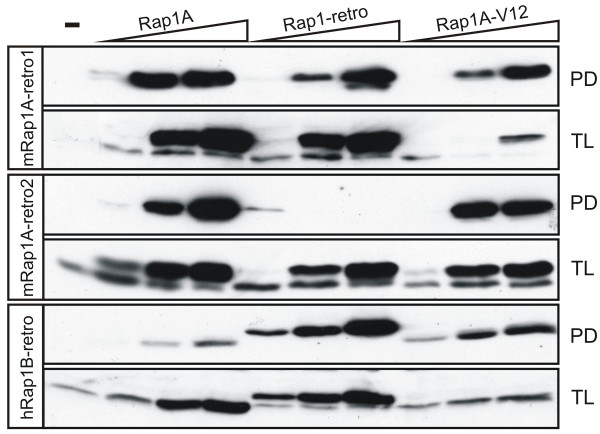
Analysis of activation of mRap1A-retro1, -retro2 and hRap1B-retro. Cos7 cells were transfected with empty vector, 0.1, 0.5 or 2 μg Rap1A (Rap1A), 0.1, 0.5 or 2 μg Rap1 retrogenes or 0.1, 0.5 or 2 μg Rap1A-V12. After 48 hours cells were lysed, and Rap1-GTP was isolated using GST-RalGDS-RBD and detected by using Western blotting with an anti-HA antibody, indicated as PD: pull down. The expression of HA-Rap1 was determined by Westernblotting using anti-HA as a probe, indicated as TL: total lysate.